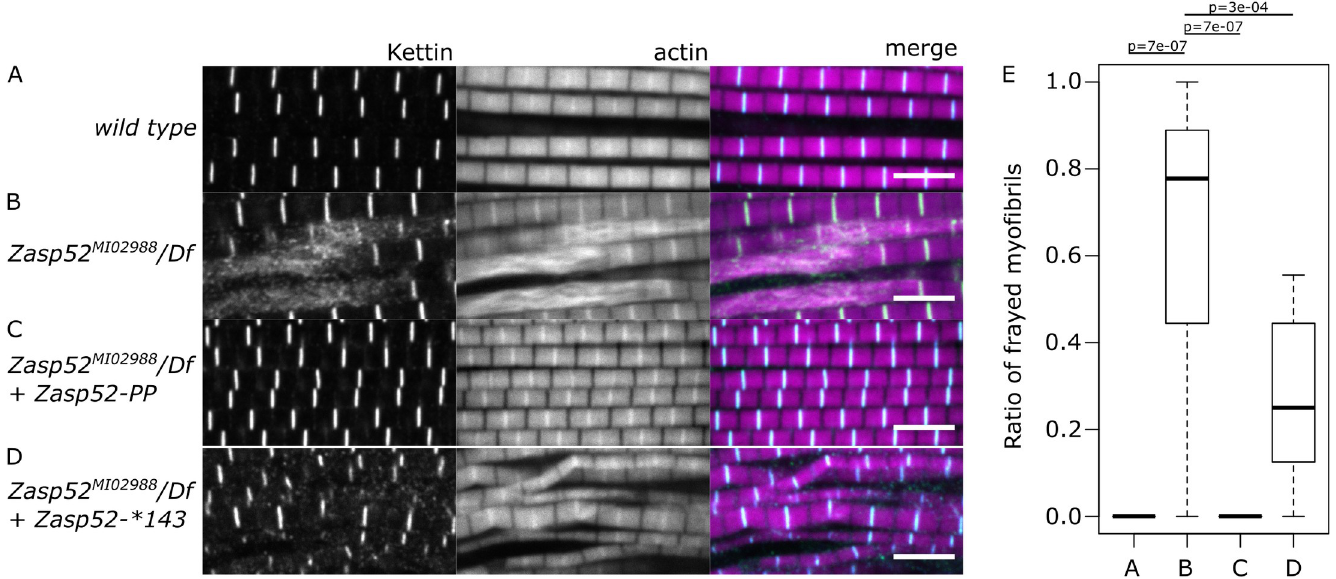
Fig 5. Limited rescue ability of a Zasp52 protein lacking the ZM region. Confocal microscopy images of IFM of different Zasp52 genetic backgrounds stained with phalloidin (magenta) to visualize myofibrils, and anti-kettin antibody (green) to visualize Z-discs. ( A ) Wild type myofibrils show no defects with properly formed sarcomeres. ( B ) In the Zasp52 MI02988 /Df , myofibrils appear frayed and the Z-disc does not form. ( C ) In Zasp52 MI02988 /Df rescued by Zasp52-PP flies, myofibrils look indistinguishable from wild type. ( D ) In Zasp52 MI02988 /Df rescued by Zasp52- � 143 muscles, myofibrils are frequently frayed and smaller. ( E ) Box plot quantification of the ratio of frayed myofibrils in different Zasp52 genetic backgrounds. UH3-Gal4 was used for the expression of Zasp52 transgenes. n = 10 muscle fibers. Scale bar, 5 μ m. P-values were calculated using Welch’s two-sample t-test followed by Bonferroni correction.